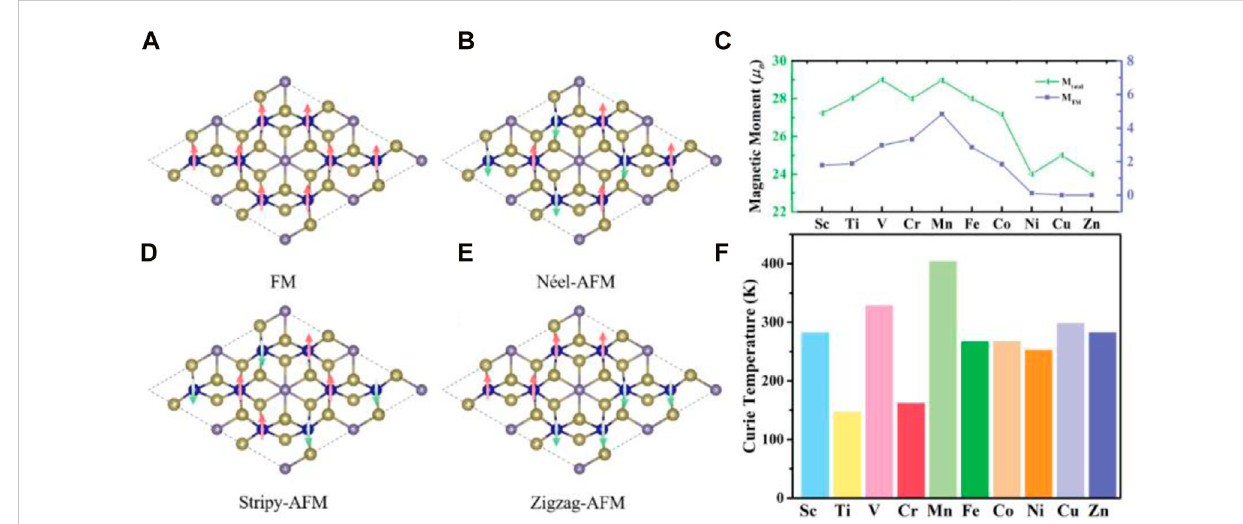
FIGURE 5 Schematics of four different magnetic structures: (A) FM, (B) Néel-AFM, (C) Stripy-AFM, and (D) Zigzag-AFM; (E) The total magnetic moment of the monolayer Cr 2 Ge 2 Te 6 absorbed with transition metals in the 2 × 2 supercell and the magnetic moment of transition metals in the monolayer Cr 2 Ge 2 Te 6 absorbed with transition metals. (F) The variation in the Curie temperature of monolayer Cr 2 Ge 2 Te 6 absorbed by conventional metals.